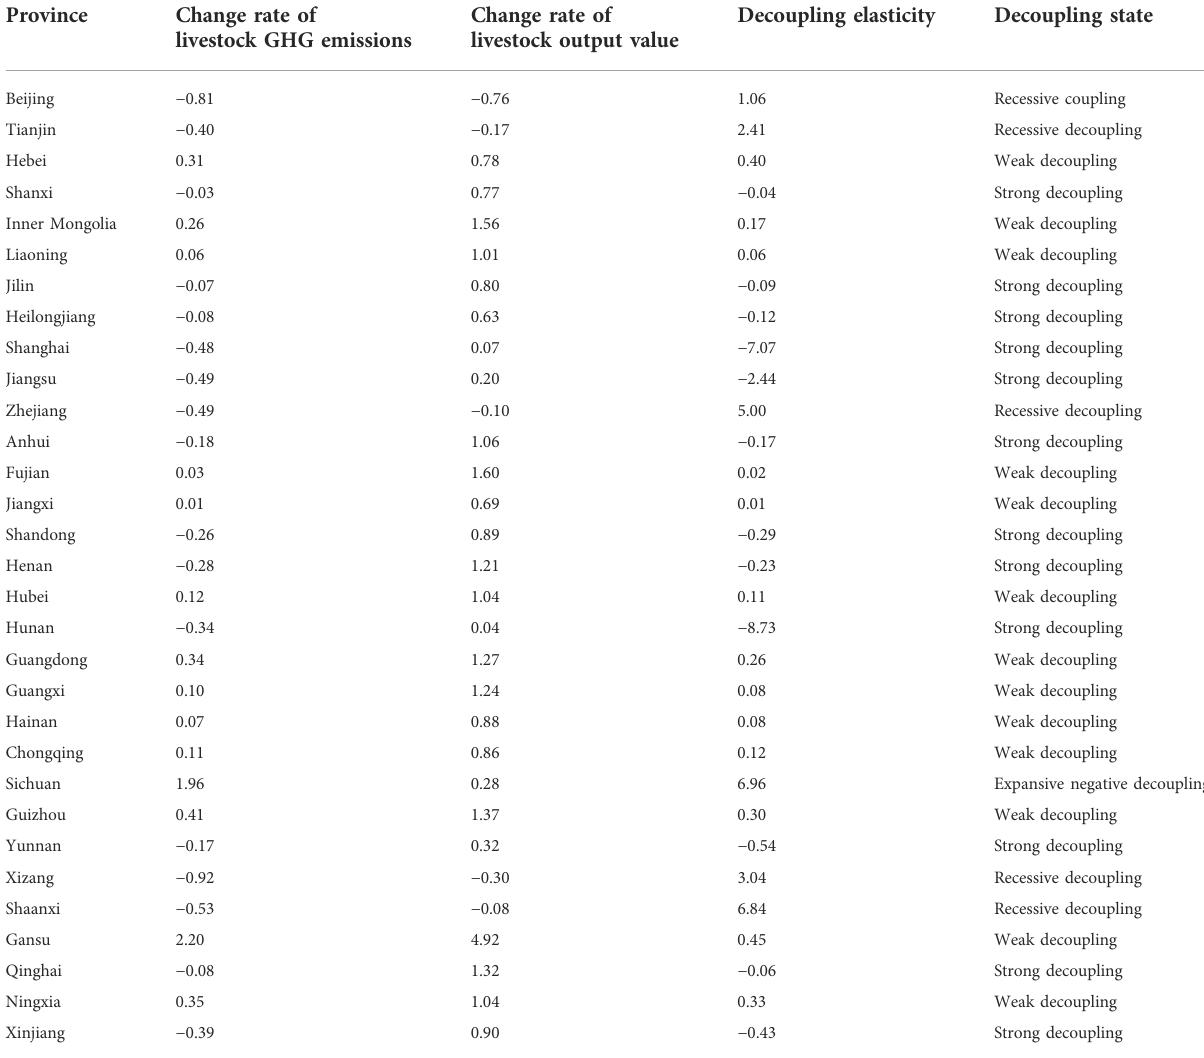
TABLE 5 Decoupling relationship between livestock GHG emissions and output value in the different provinces ’ CAGDMZ from 2010 to 2019.